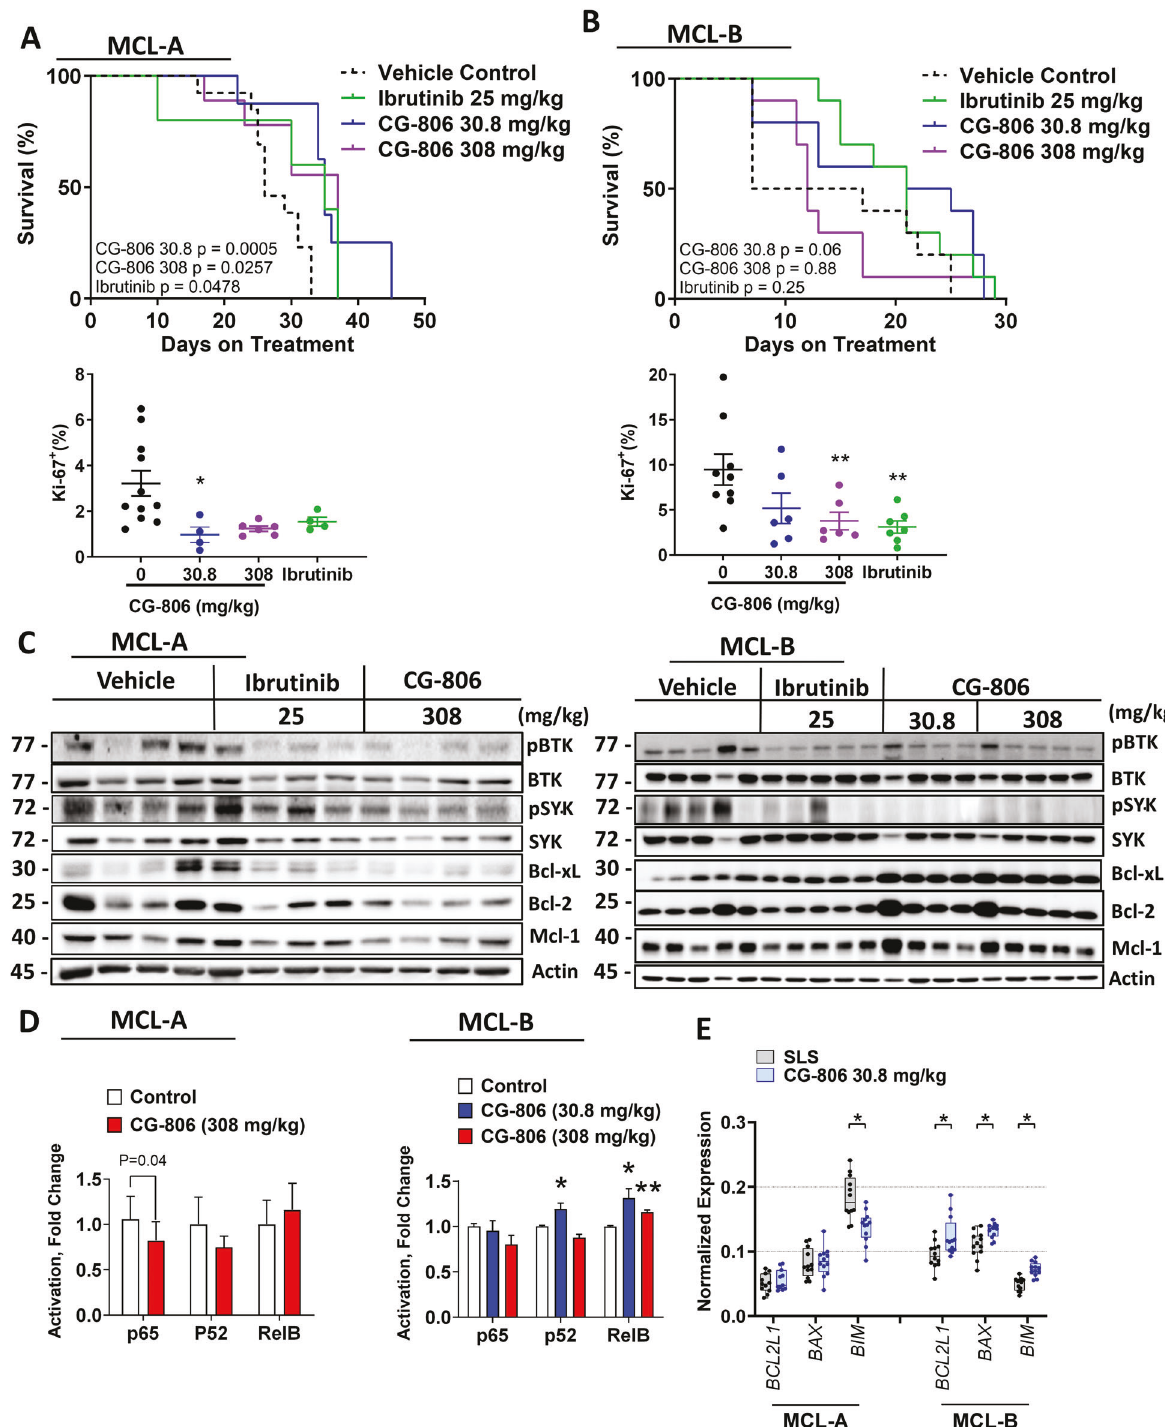
Fig. 3 CG-806 restricts MCL development and BCR signaling in vivo. A – C Mice were inoculated with MCL cells as described in the methods. Two distinct MCL PDX models were used. Once circulating CD5/CD19 + MCL cells were detected in the peripheral blood, mice began daily treatment with CG-806, ibrutinib, or vehicle control via oral gavage in the indicated doses. Kaplan – Meier survival curves are shown, signi fi cance determined by log-rank test. At the end of the experiment, mice were euthanized 2 h after the fi nal drug dose, and spleen- resident tumor cells were analyzed for proliferation and were subjected to immunoblotting. D NF- κ B activation in splenocytes from MCL-A ( N = 8) and MCL-B ( N = 5) mice was quanti fi ed using the TransAm NF- κ B Activation Assay. E mRNA expression of the indicated gene transcripts was quanti fi ed using RT-PCR and normalized to GAPDH. Data are shown as a box and whisker plot with dots representing expression values from four mice. * p < 0.05 and ** p < 0.01 vs. vehicle control.